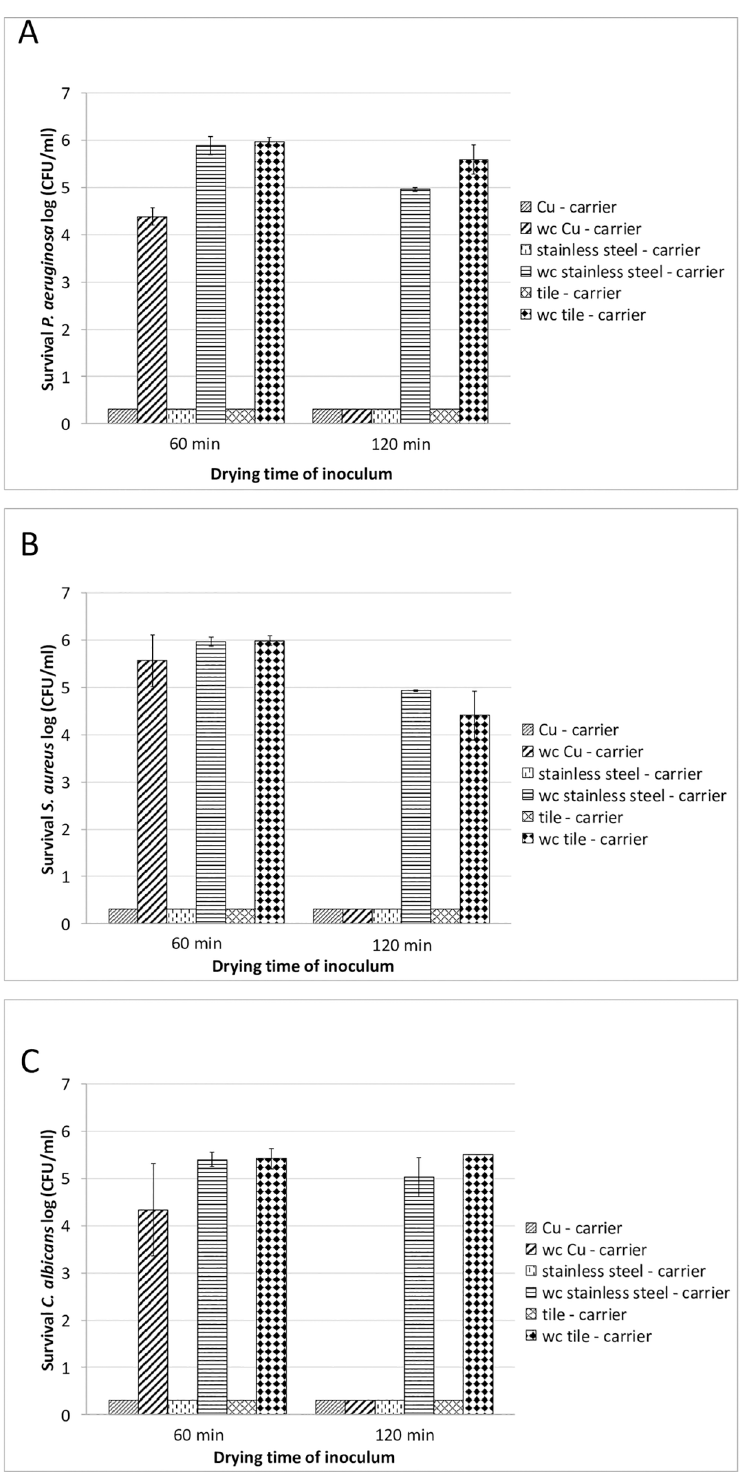
Fig 3. Investigation of antimicrobial efficacy of an alcohol based-disinfectant on copper alloy (CuZn23AlCo). Antimicrobial efficacy tests were carried out using the DGHM carrier test without mechanical action and without organic soiling [16]. Microbial inocula were dried for either 60 min or 120 min, as indicated. 100 μl disinfectant was applied to the different carriers (copper alloy carriers, stainless steel carriers, tile carriers) with a contact time of 2 min.